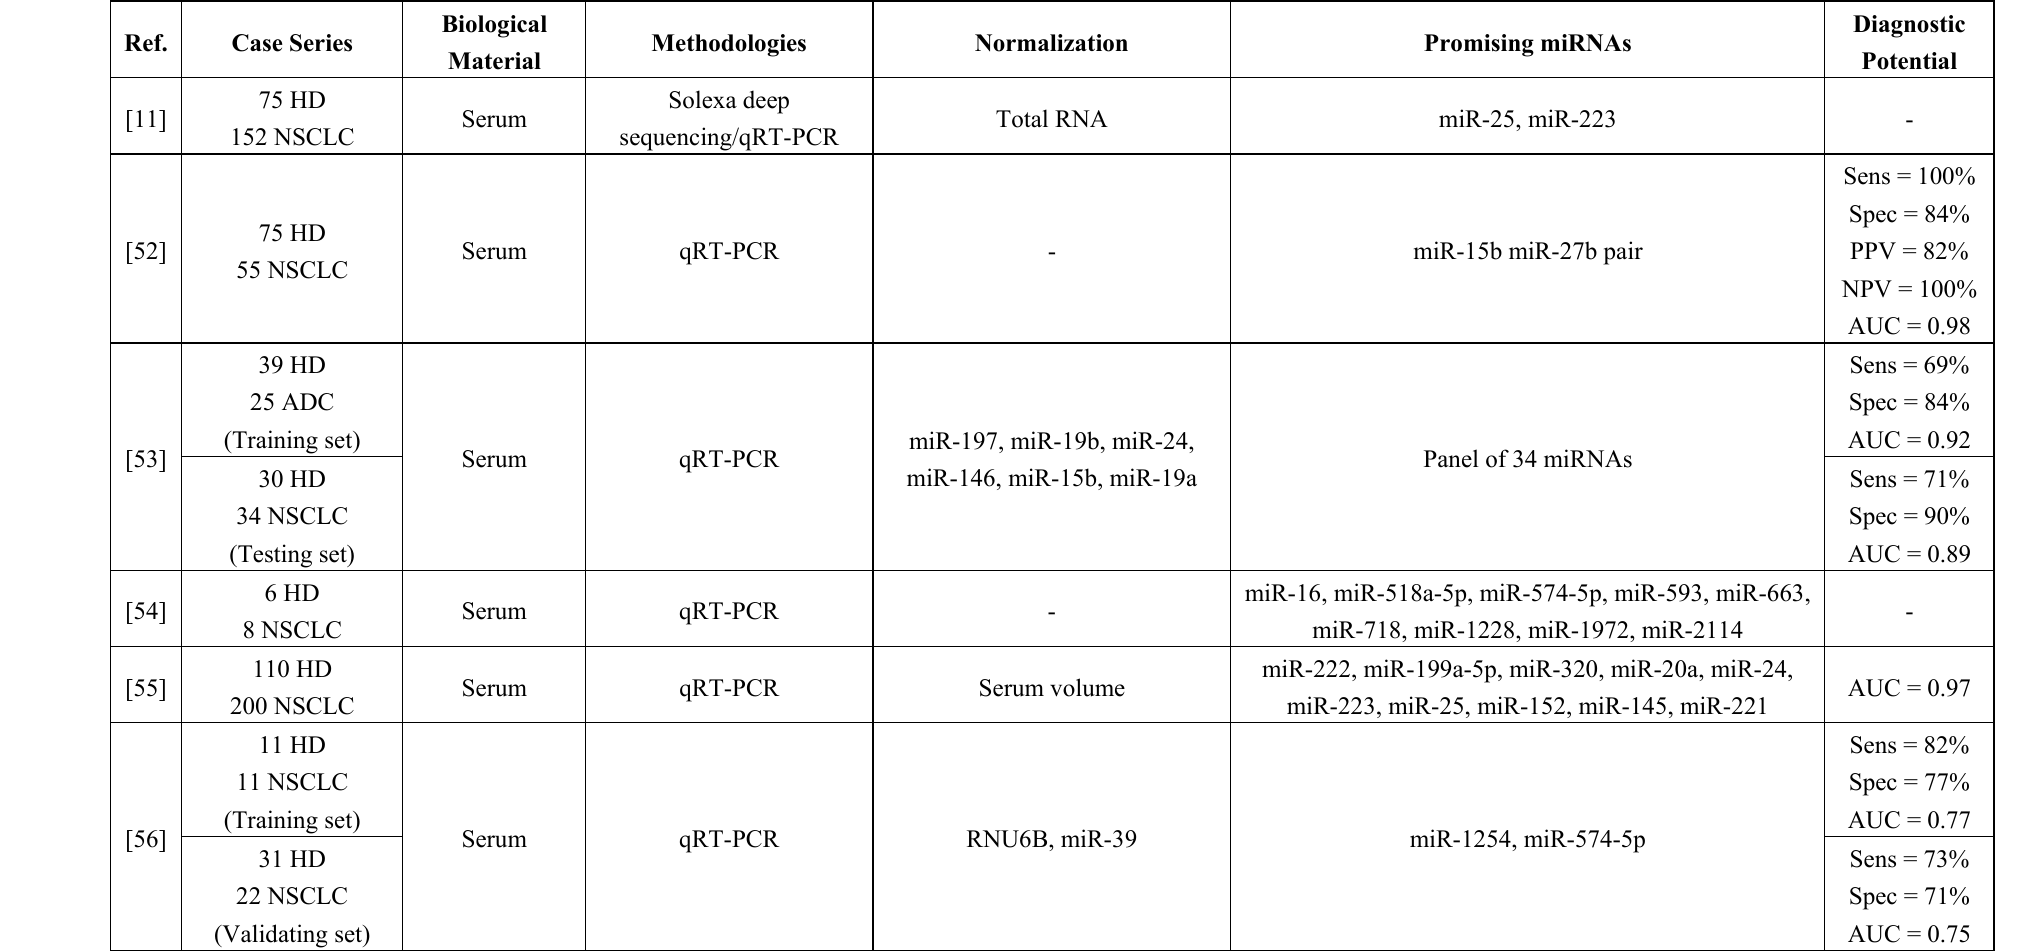
Table 1. Studies on circulating miRNAs as biomarkers for lung